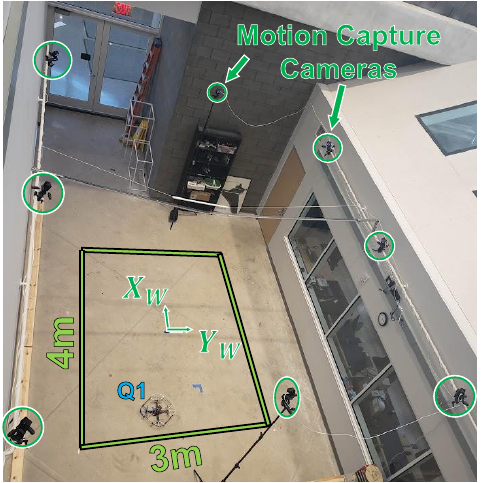
Figure 2. Flight vehicle Q1 in the Robot Fly Lab within the Ford Motor Company Robotics Building at the University of